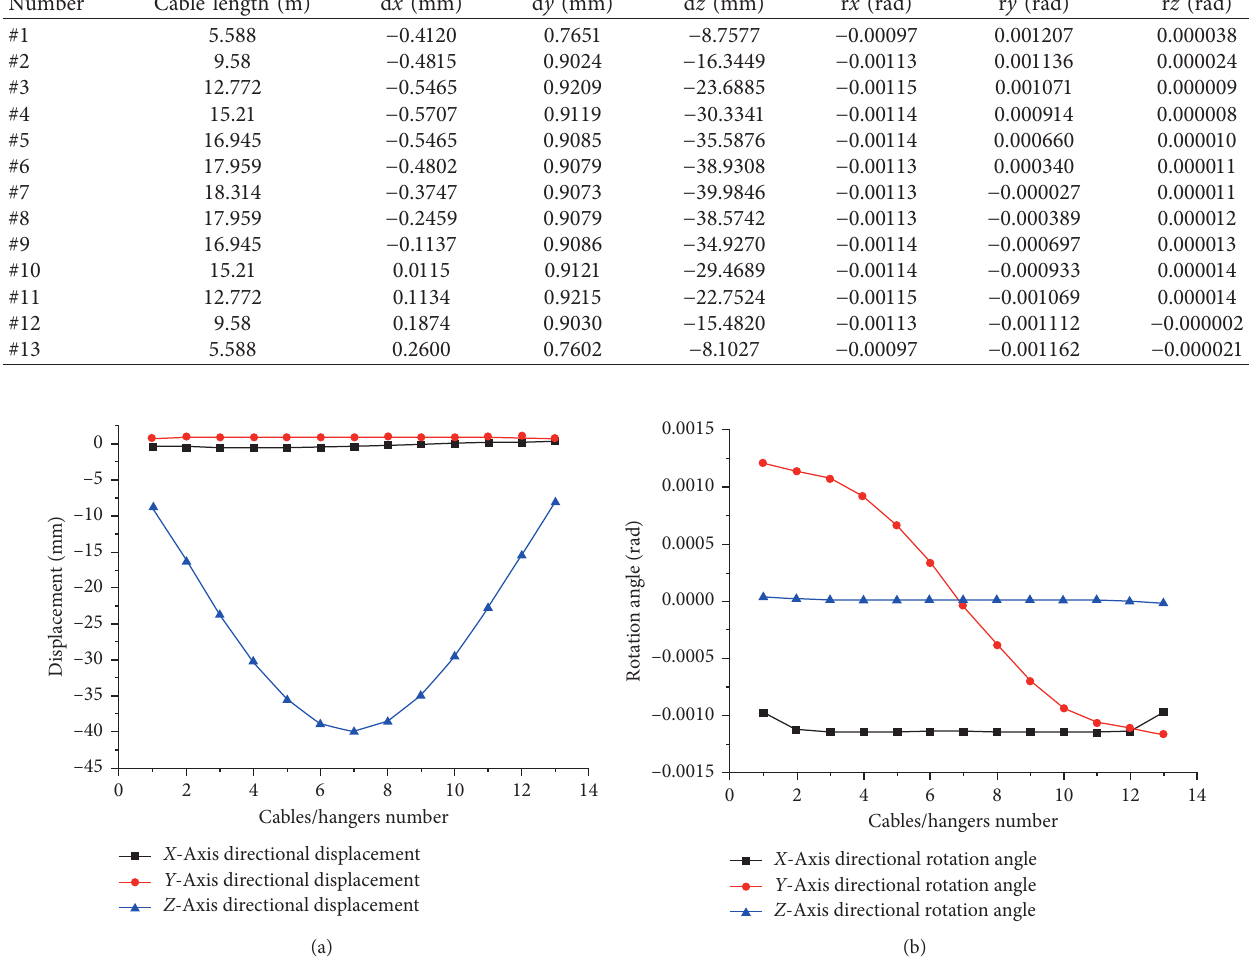
Figure 4: Displacement and angle curve of lower anchorage zone: (a) displacement curve of the lower anchorage zone; (b) R-angle curve of the lower anchorage zone.